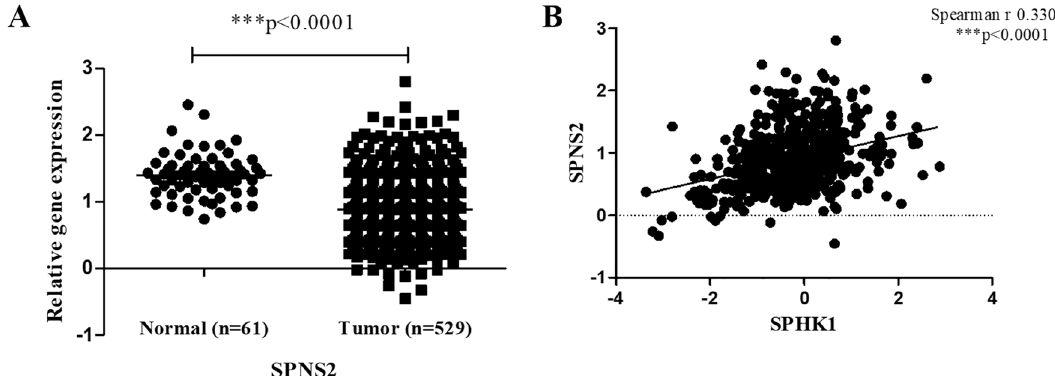
Figure 11. Expression of SPNS2 in TCGA cohort. ( A ) Relative gene expression between adjacent normal and tumor tissue, ( B ) Correlation with SPHK1